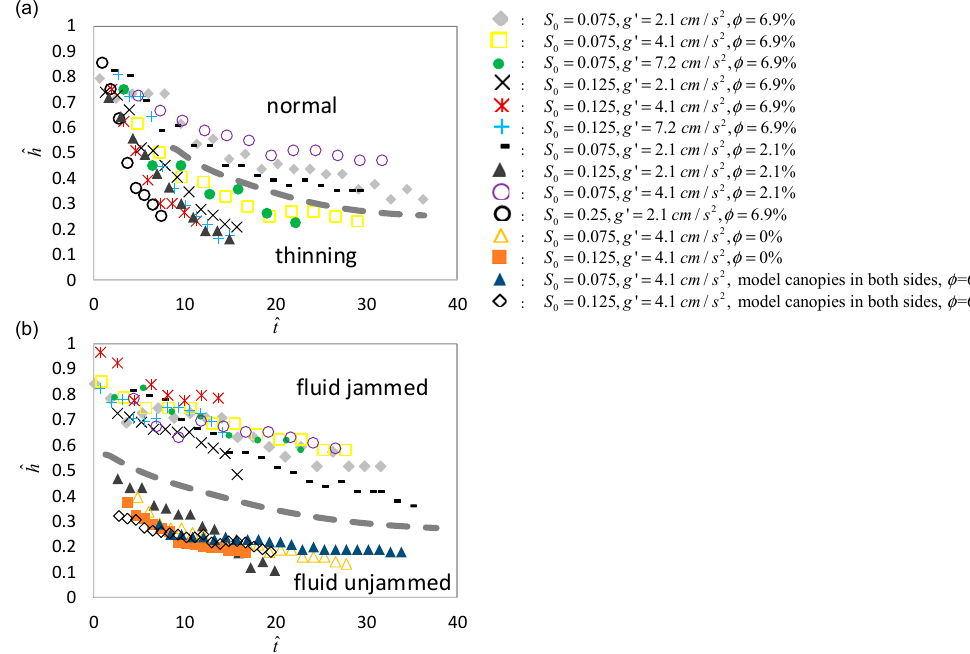
Figure 8. Temporal progression of the interface at a slope of 0.125 (~7.1 ◦ ) and g (cid:48) = 7.2 cm/s 2 : ( a ) Run 34 ( ϕ = 0% in shallows, and ϕ = 6.9% in deep regions); and ( b ) Run 33 ( ϕ = 6.9% in shallows, and ϕ = 0% in deep regions).